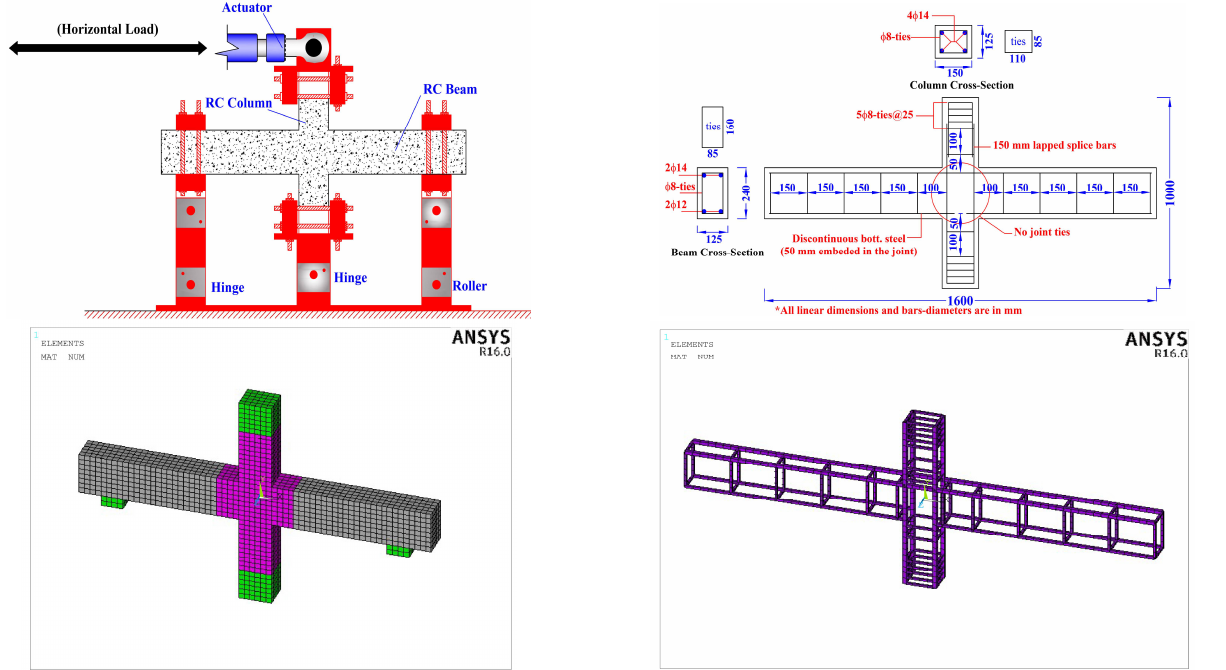
Figure 1. Testing details comparison; Experimental [33] and NLFEA [54].